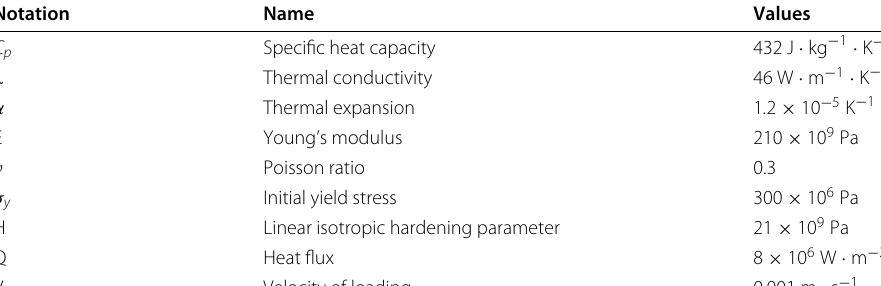
Table 1 Material properties and load data